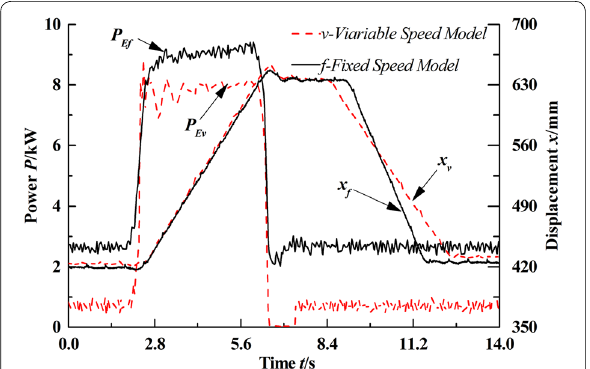
Figure 16 Electric power input and displacement of the